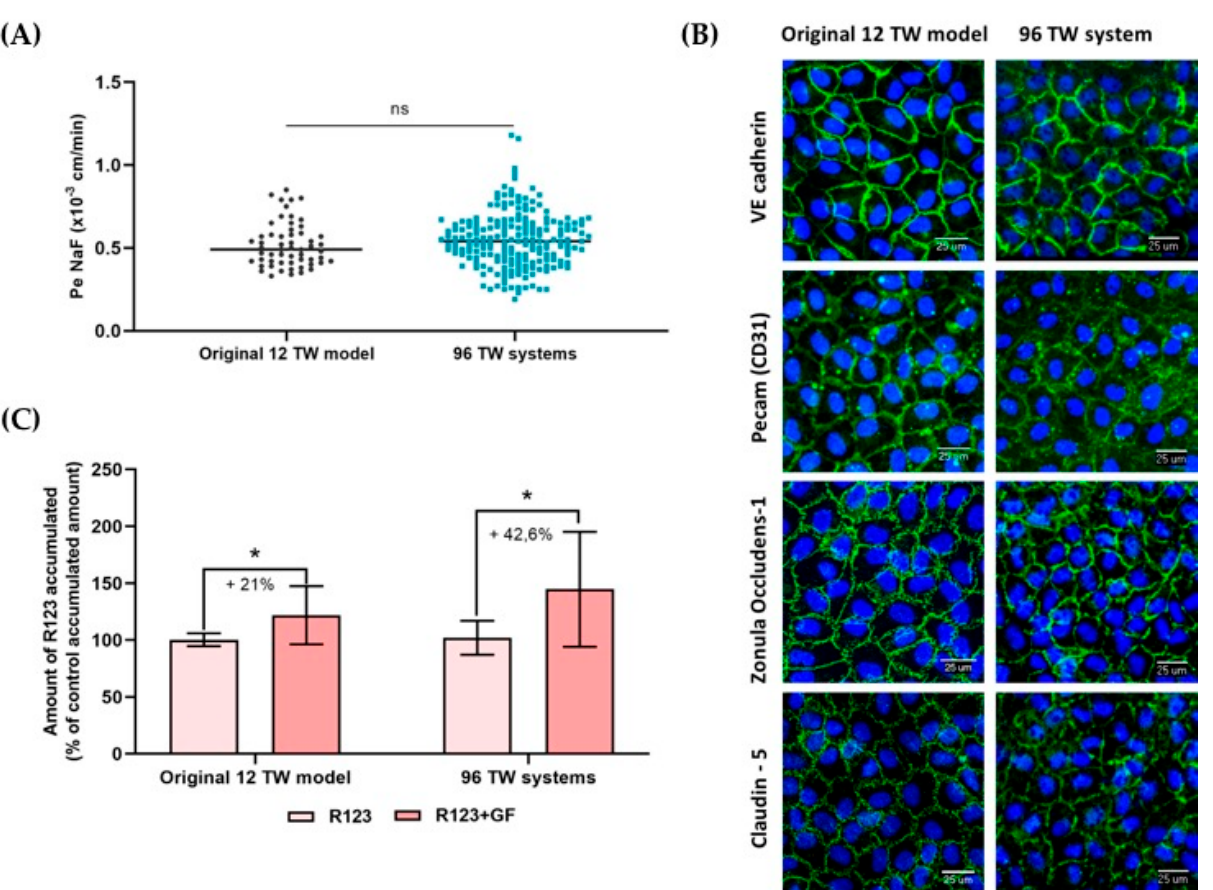
Figure 5. BBB phenotype comparison between the original 12 TW model and the miniaturized 96 TW system. ( A ) Endothelial permeability coefficient (Pe in cm/min) measuring the transport of sodium fluorescein (NaF) through the BLECs in the original 12 TW model and the miniaturized 96 TW system over the different cell seeding series. The results are presented in a scatter plot for the original 12 TW models: n = 57, N = 19 and 96 TW systems: n = 194, N = 22 (unpaired t -test; ns = no significant differences). ( B ) Immunocytochemical CD34 + -ECs BBB phenotype validated by the expression of the proteins involved in the junctions (in green): VE cadherin, PECAM (CD31 + ), Zonula occludens-1 and Claudin-5. Nuclei are in blue. Original 12 TW images were taken from the luminal BLEC face, while images in the 96 TW system were taken from the abluminal BLEC face, using the ImageXpress Micro Confocal High-Content Imaging System, objective 20× (scale bar = 25 µm). ( C ) Assessment of the efflux pump functionality. Percentage of the R123 intracellular accumulation in the BLECs in the presence or absence of the inhibitor Elacridar (GF) in the original model and in the miniaturized model. Samples: n = 9, N = 3 (multiple t -test; * p- value < 0.05).